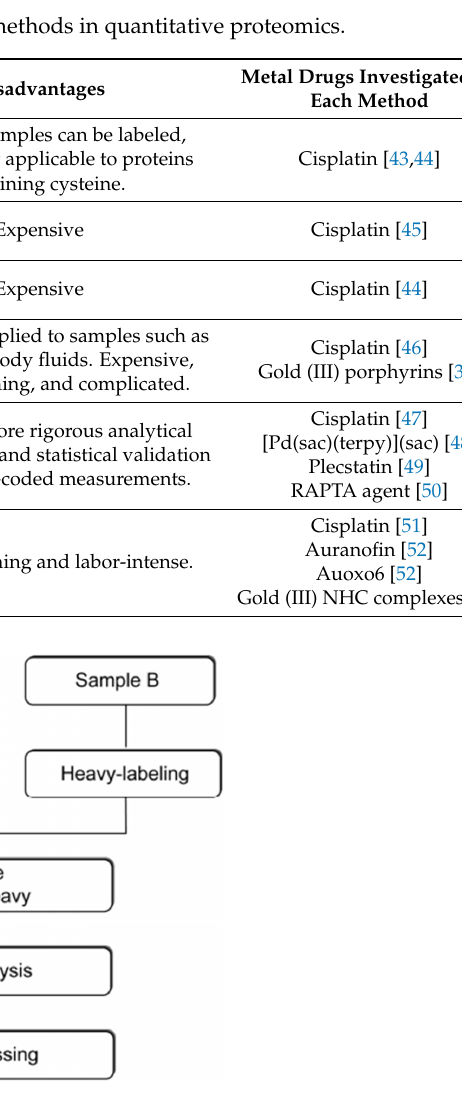
Figure 5. The workflow of stable isotope labeling-based quantitative proteomics. This figure is adapted from reference [44].